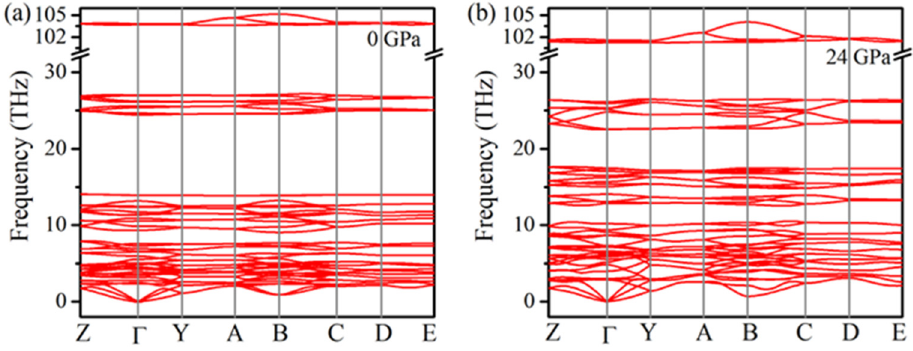
Figure 10. Phonon dispersions of the P2 1 /a phase of Cu(OH)Cl at selected pressures. ( a ) At 0 GPa. ( b ) At 24